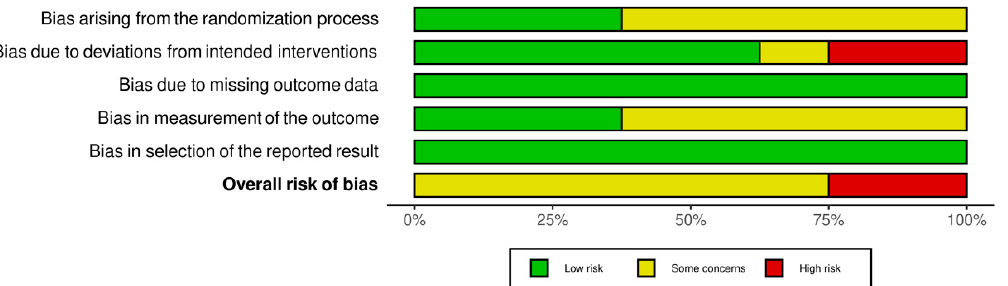
Figure 4. Risk of bias in non-randomized control trials (green: low bias risk; yellow: moderate bias risk; red: serious bias risk; brown: critical bias risk; blue: no information). Figure 5. Percentages of risk bias in non-randomized control trials (green: low bias risk; yellow: moderate bias risk; red: serious bias risk; brown: critical bias risk; blue: no information).